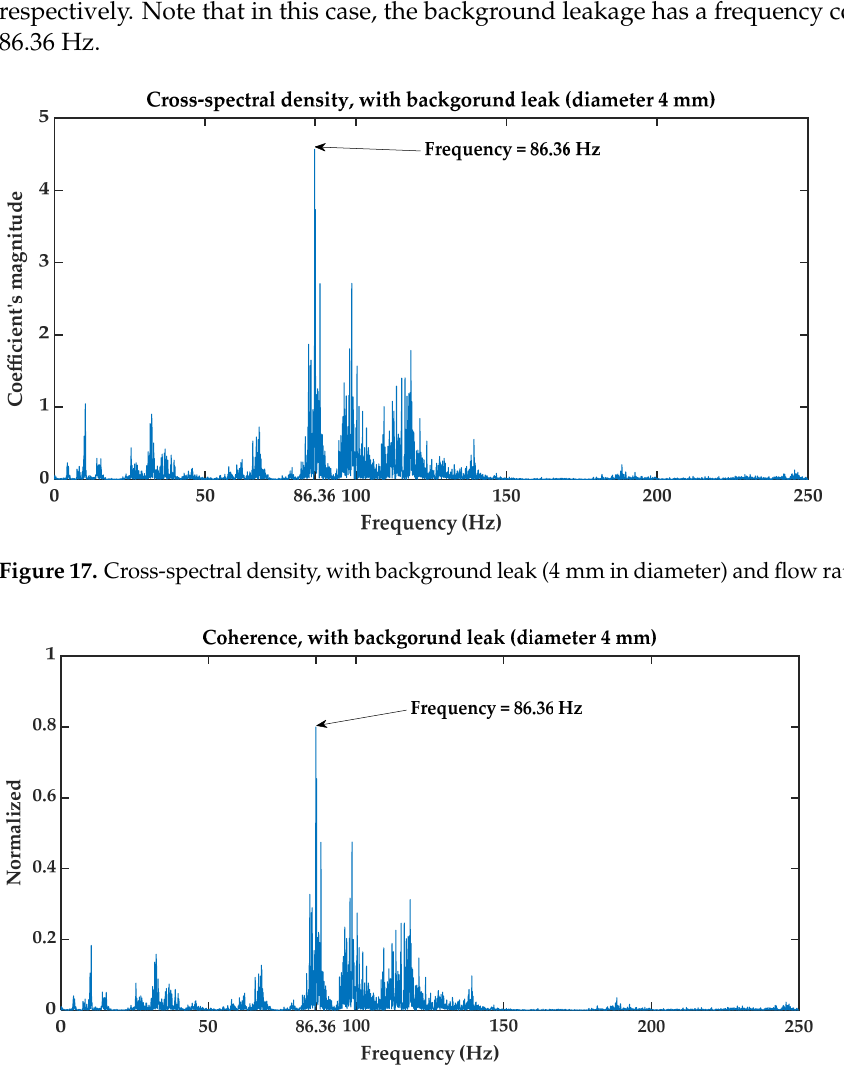
Figure 16. 𝒯 (cid:3032) coherence in Scale 4 , with background leak ( 1 mm in diameter) and flow rate